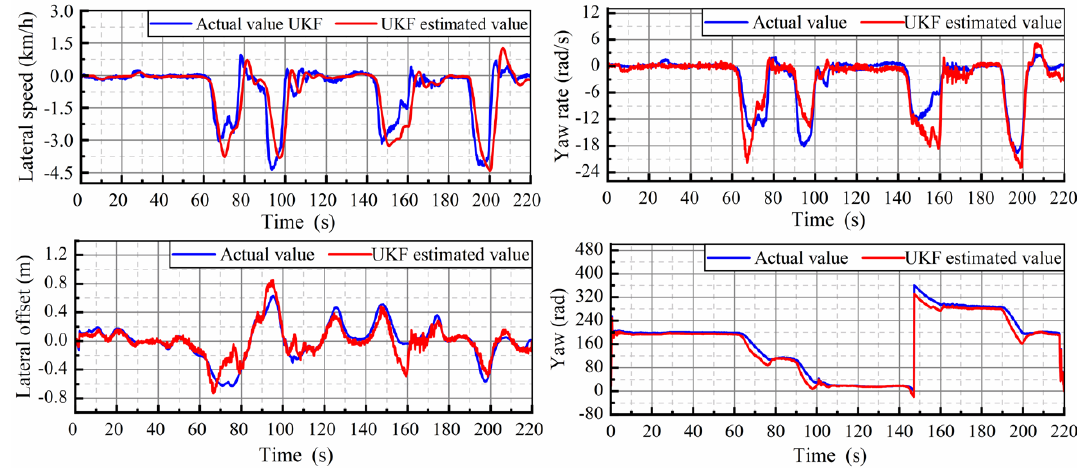
Figure 9. Vehicle state estimated value.